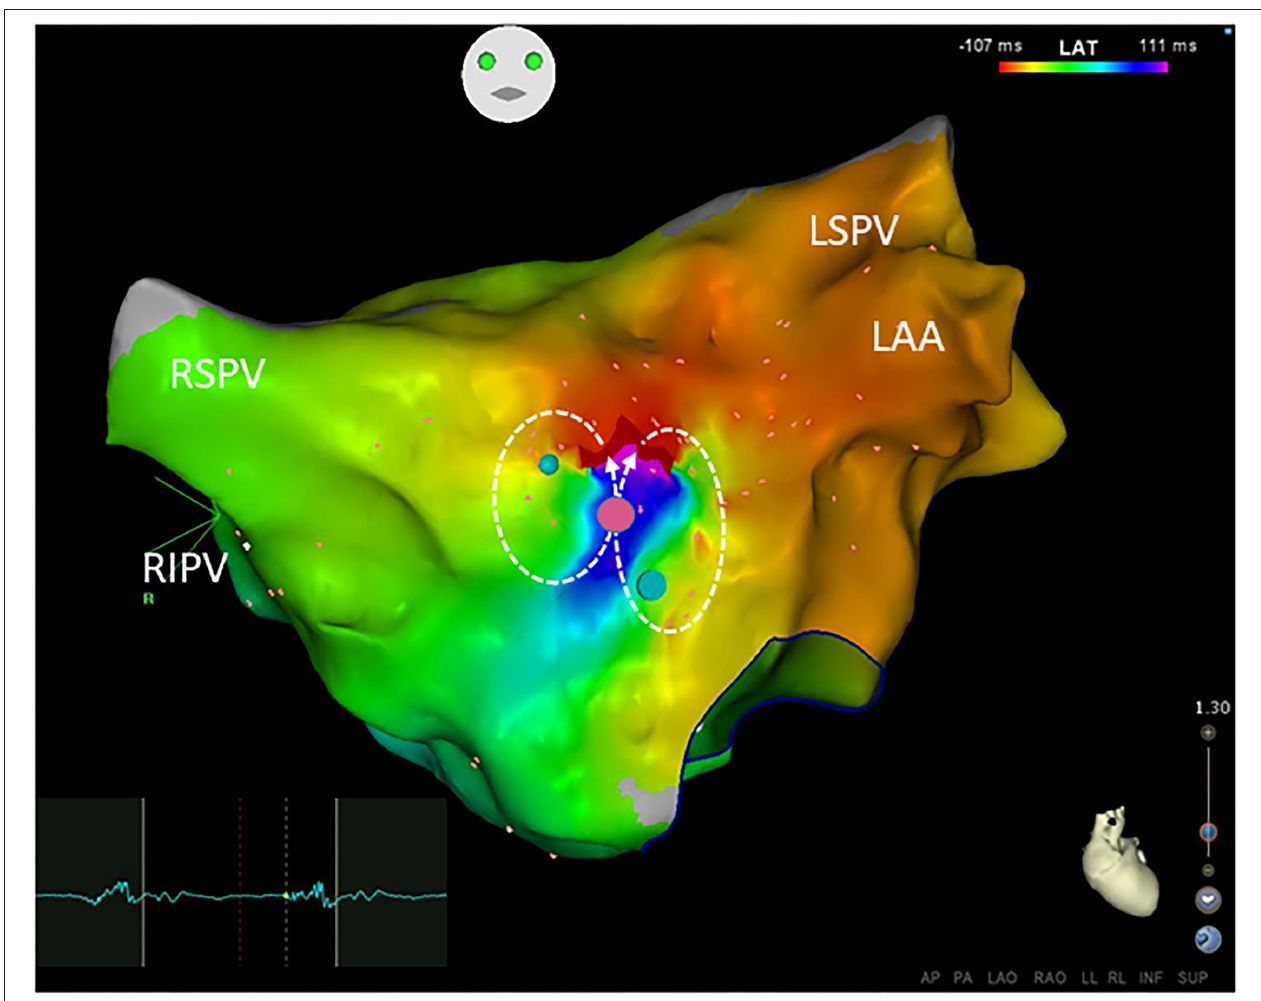
FIGURE 4 | Small-loop-reentrant atrial tachycardia with a figure-of-eight pattern was demonstrated by the Carto system. The reentrant circuits located at the anterior wall of the left atrium were within an area with a diameter of < 30mm but > 10mm. The phenomenon of early (red) meeting late (purple) wavefront was shown in the activation map. A narrow isthmus area with an FP (electrogram on the left) at a pink dot was shown and confined by small regions of the scar. Blue dots define double potentials and dotted arrows show the activation directions. Ablation targeting on the FP terminated the atrial tachycardia. Abbreviations as shown in Figures 1 , 2